Question: Write a single sentence explaining what this figure depicts.
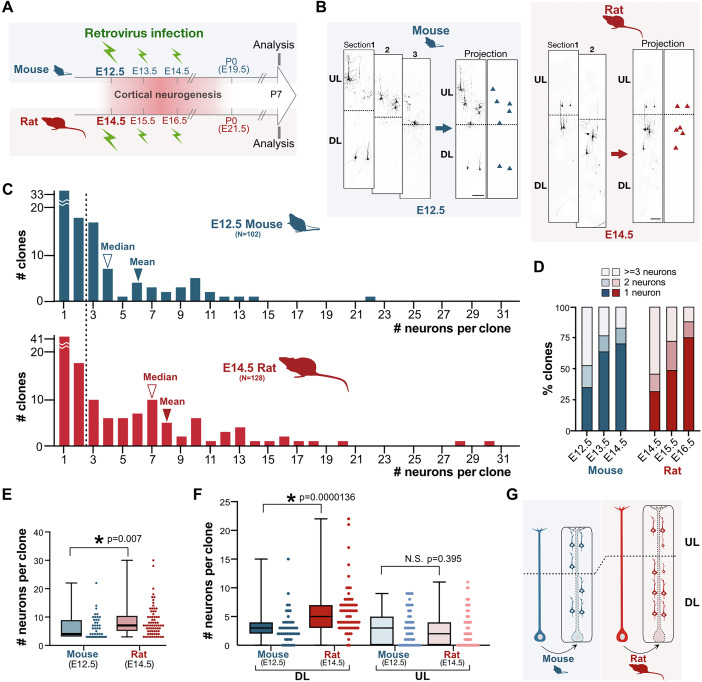
Answer: Clonal production of cortical excitatory neurons in mice and rats. ( A ) Time course of clonal analysis in the mouse and rat cerebral cortices. Retroviral injections were performed at the onset of neurogenesis (E12.5 in mice and E14.5 in rats), and animals were sacrificed at P7 for analysis. ( B ) Representative examples of cortical excitatory neuron clones in mice and rats. Scale bars: 100 μm. ( C ) Distribution of clone sizes when retroviruses were injected at the onset of neurogenesis. Clonal sizes represent the number of neurons generated by individual RG progenitors. Median and mean of clone size are indicated by open and filled arrowheads, respectively. ( D ) Percentage of clones containing one, two, or three or more neurons in mice and rats. ( E ) Comparison of clone size between species. Only clones with three or more neurons were analyzed. n mouse_E12.5 = 47 clones, n rat_E14.5 = 69 clones. ( F ) Distributions of upper layer (UL) and deep layer (DL) neurons per clone. Rats exhibit a marked increase in the number of DL neurons per clone compared to mice, while UL neuron numbers remain similar between the species, n mouse_E12.5 = 47 clones, n rat_E14.5 = 69 clones. ( G ) Schematic diagram summarizing the clonal analysis results (mean number of neurons per clone), highlighting species-specific differences in DL neuron production. For box plots in ( E , F ), the center line indicates the median (50th percentile), the bounds of the box indicate the 25th and 75th percentiles, and the whiskers extend to the minimum and maximum values. Statistical analysis was performed using Welch’s t test, with detailed results available in Dataset EV1 . Asterisks indicate statistical significance ( P < 0.05).